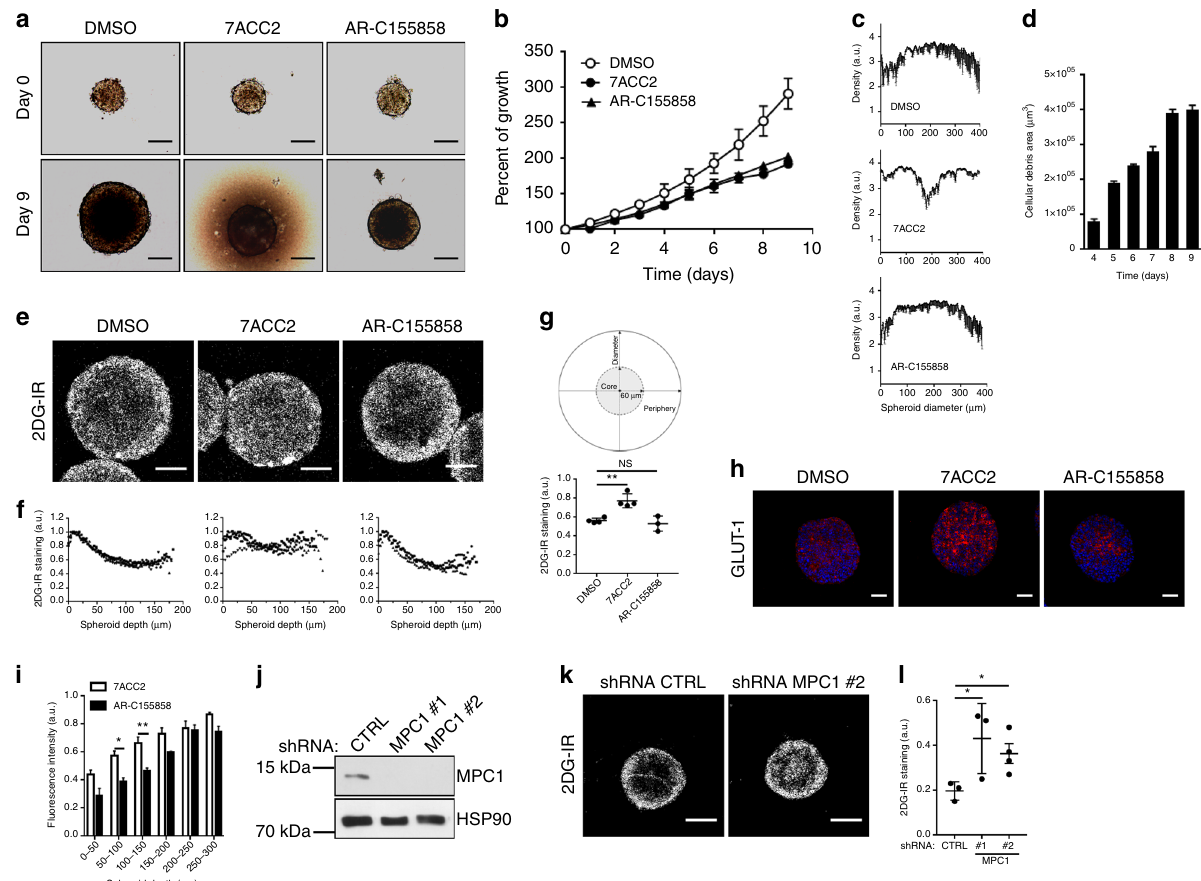
Fig. 5 7ACC2 and AR-C155858 reduce the growth of tumor spheroids through different mechanisms. a Representative pictures and ( b ) time-dependent growth of FaDu spheroids upon treatment with 20 µ M 7ACC2 or AR-C155858 for 9 days. Scale bars: 200 µ m. c Cellular density within FaDu spheroids treated as indicated in a for 9 days. d Time-dependent accumulation of cellular debris (i.e., appearance of a brown ring surrounding spheroids) from FaDu spheroids treated with 20 µ M 7ACC2. e Representative immuno fl uorescence pictures and quanti fi cation of 2-deoxyglucose-IRDye (2DG-IR, 3 h exposure), ( f ) distribution from the periphery to the core and ( g ) accumulation within the core of FaDu spheroids pre-exposed to 20 µ M 7ACC2 or AR-C155858 for 24 h. Scale bars: 100 µ m. h Representative immuno fl uorescent pictures and ( i ) corresponding quanti fi cation (at the indicated spheroid depth) of GLUT-1 staining in FaDu spheroids treated with 20 µ M 7ACC2 or AR-C155858 for 5 days. Scale bars: 100 µ m. j Representative immunoblotting for MPC1 in FaDu cells expressing control or MPC1-targeting shRNA sequences. k Representative immuno fl uorescence pictures and ( l ) quanti fi cation of 2DG-IR within the spheroid core (as in g ) in FaDu spheroids expressing control or MPC1-targeting shRNA. Scale bars: 200 µ m. Data are represented as mean ± SEM of three independent experiments (with ≥ 6 technical replicates). Signi fi cance was determined by one-way ANOVA ( g , l ) or two-way ANOVA ( i ) with